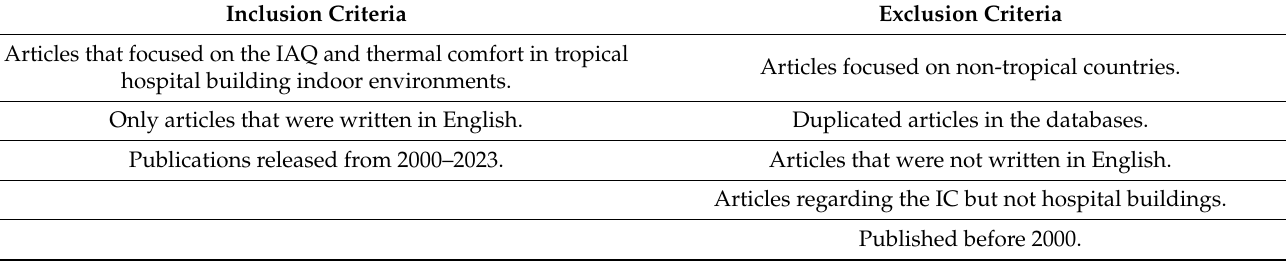
Table 1. Inclusion and exclusion